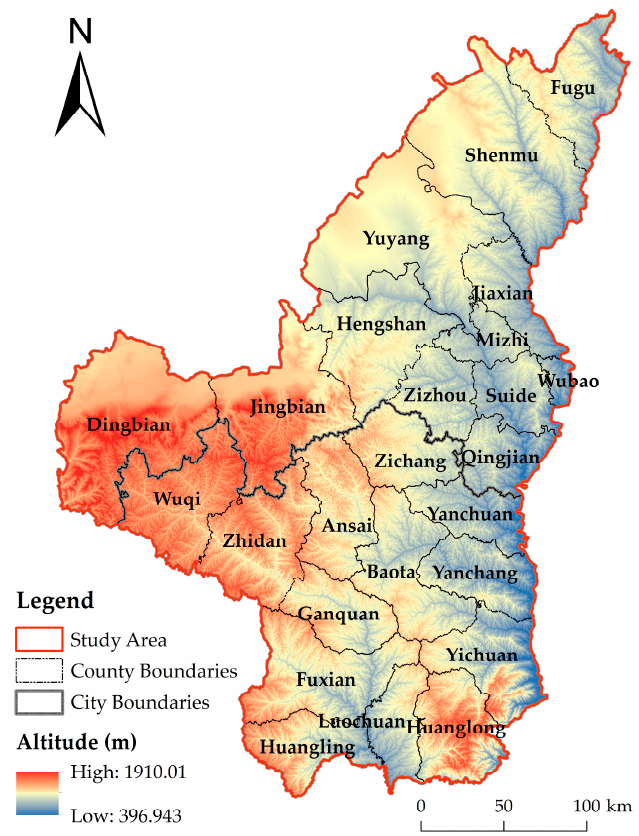
Figure 1. Schematic diagram of the study area.